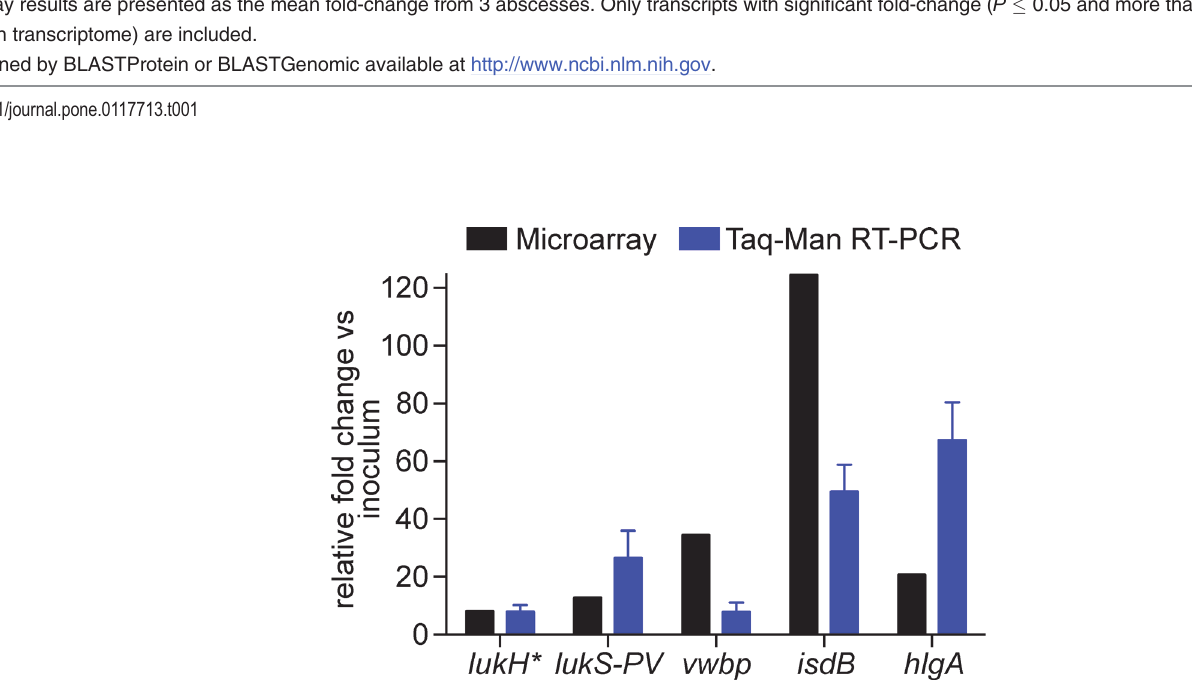
Fig 1. TaqMan real-time PCR verification of changes in S . aureus transcript levels. Results are expressed as an average relative fold change in bacterial transcripts from three abscesses excised 24 h post infection and compared to the level of bacterial transcript expression in the inoculum. The relative quantification of S . aureus transcript was determined by the change in expression of target transcripts relative to that of gyrB . * Also known as lukA